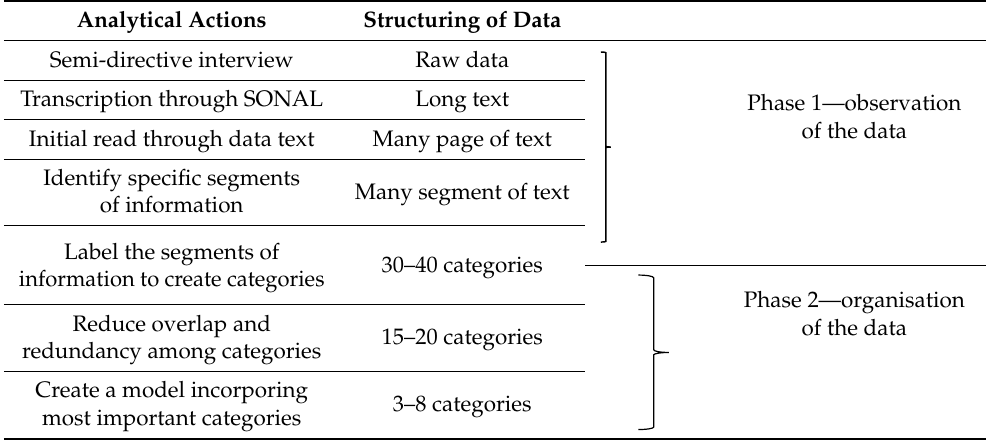
Table 1. The coding process in the inductive analysis (based on Thomas [44], redrawn from Creswell [45]).